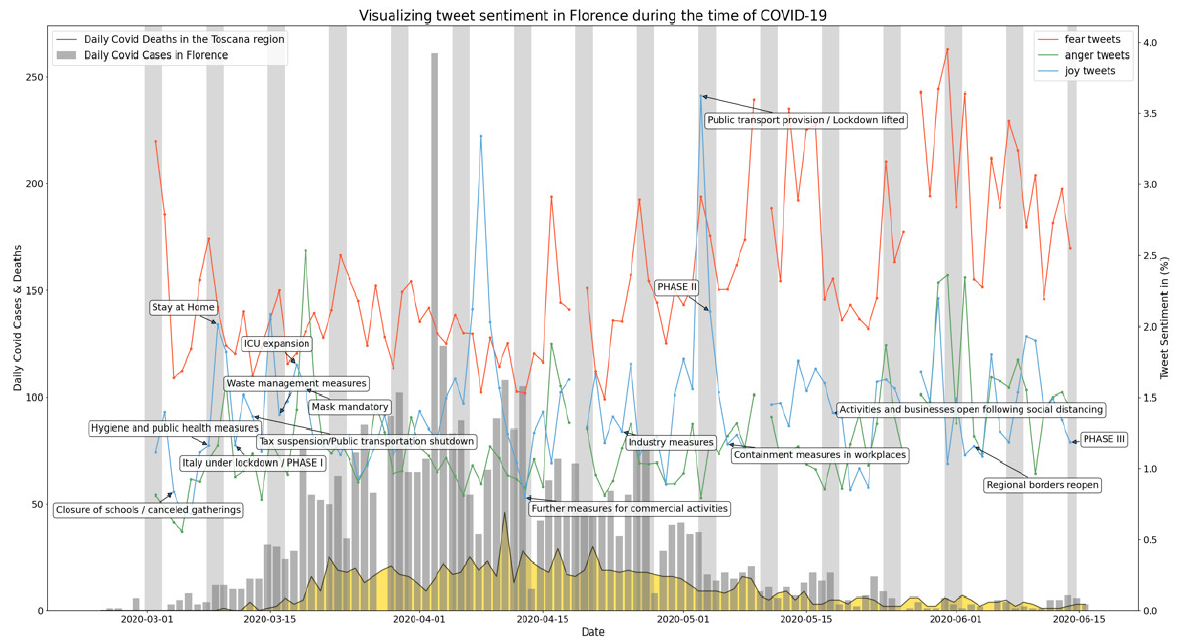
Figure A5. Visualizing Twitter sentiment in Florence during the time of COVID-19.